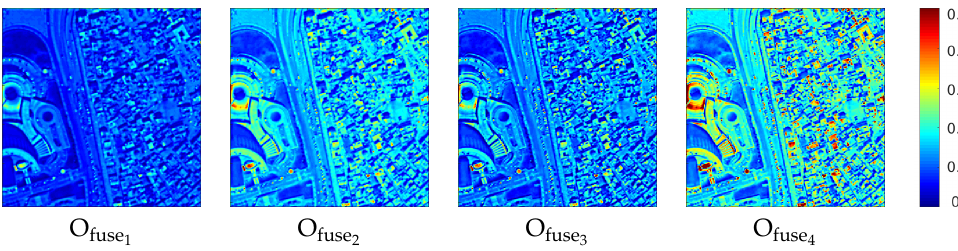
Figure 4. Schematic diagram of the average value of all bands in the feature map after normalization. The placement order is from left to right in accordance with the output